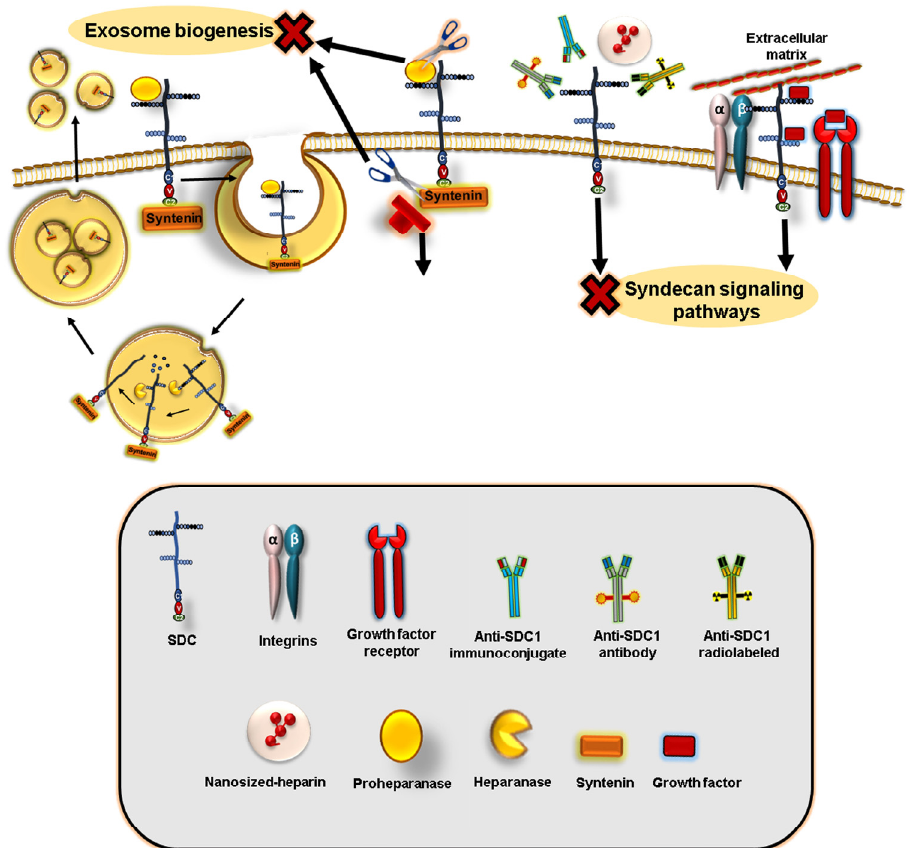
Figure 4. Summary diagram for di ff erent therapeutic approaches that can be used for syndecans (SDCs) targeting breast cancer. This includes monoclonal anti-SDC1 antibodies, immunoconjugates linked to cytotoxic drugs, or radiolabeled antibodies (immunoradiotherapy). Further therapeutic perspectives include the application of different types of pharmaceutical agents or inhibitors, such as peptide inhibitors (to impede their interactions with integrins or RTKs), small molecule inhibitors, and HS mimetics (or their nanoformulations, e.g., nanoheparin), or inhibitors for exosomal packing (e.g., SyntOFF inhibitors targeting the PDZ2 domain of syntenin). For further details, please refer to the text.